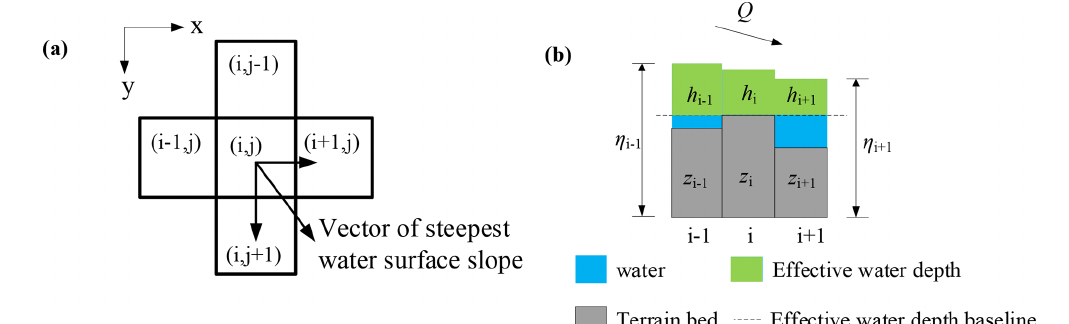
Figure 1. Typical grid and water depth